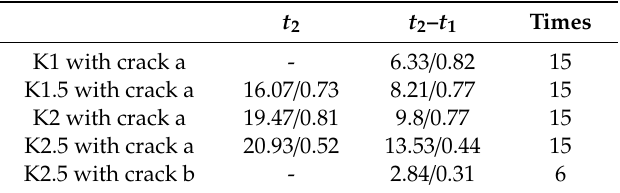
Table 5. Propagation time in EXP3 (mean / standard deviation), µ s.